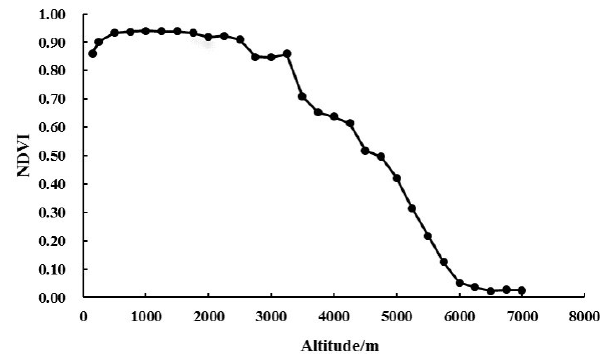
Figure 7. Distribution of NDVI along the elevation of the Yarlung Zangbo River